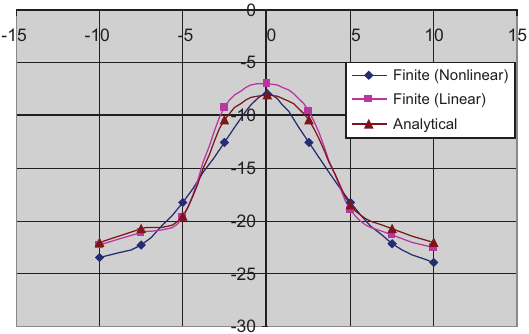
Figure 1 Geometric structure of a double-lap joint.